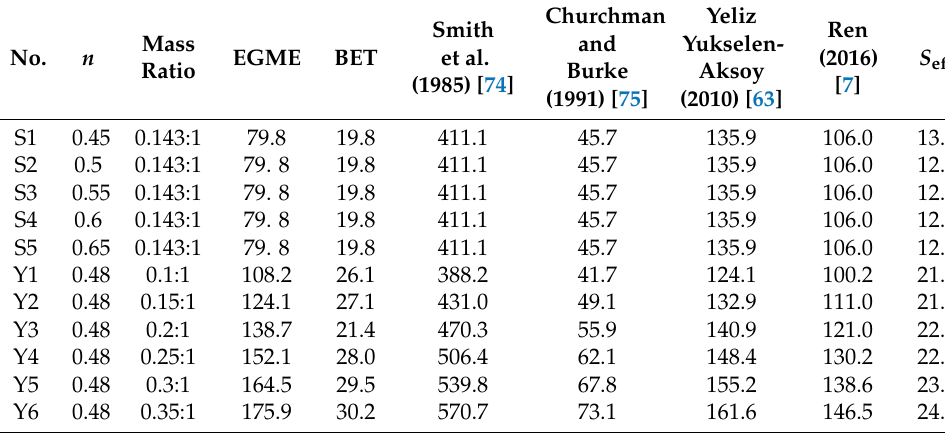
Table 3. SSA for two type soil by different method (m 2 /g).